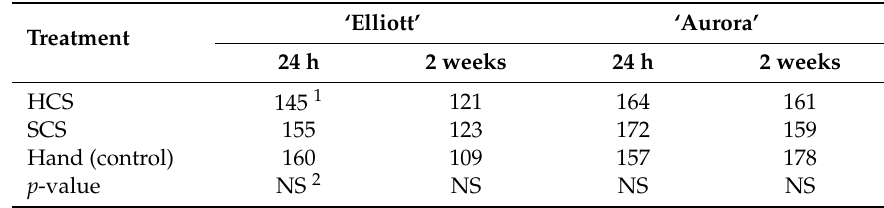
Table 3. Firmness (g/mm) of ‘Elliott’ and ‘Aurora’ blueberries 24 h and 2 weeks after machine harvesting using a modified over-the-row harvester prototype with Orbirotor ® picking heads and experimental hard and soft catch surfaces (HCS and SCS, respectively) in Washington. Machine harvested berries were compared to hand-harvested (control) fruit in 2017.